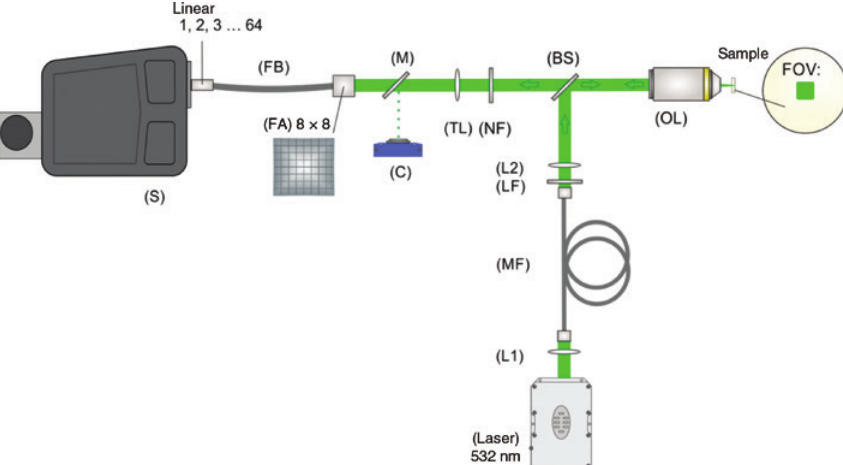
Figure 10: Sketch of the experimental setup for fiber array-based Raman hyperspectral imaging. The rectangular area of illumination in the focal plane is achieved with a long propagation length of the laser light within a step index multimode fiber (MF). The backscattered signal is imaged onto an 8 × 8 fiber array. The fiber arrangement within the fiber bundle (FB) changes from 8 × 8 square to 64 × 1 line. The linear array is positioned in the slit plane of the spectrometer enabling hyperspectral imaging with reduced effort for acquisition. Adapted from Frosch et al. [103], reproduced with the kind permission of